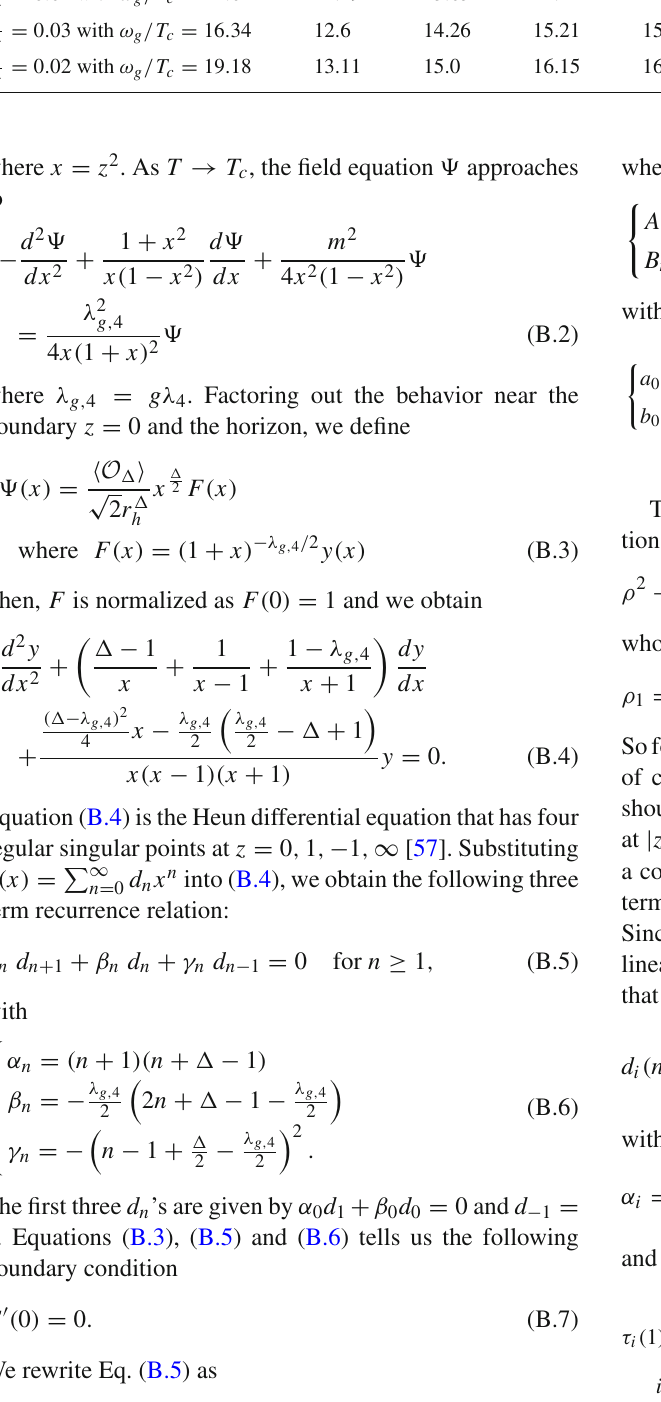
by applying Mathematica T c ω 7 ω 8 T c T c